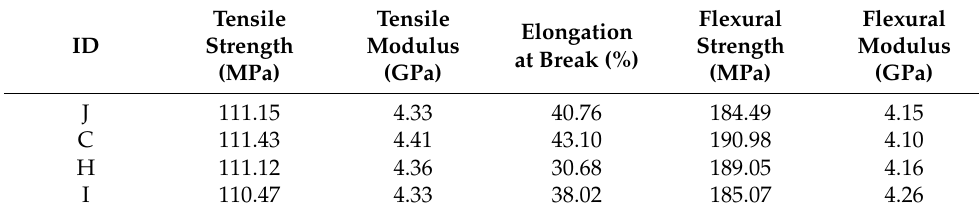
Table 6. Tensile and bending properties under different hot compression